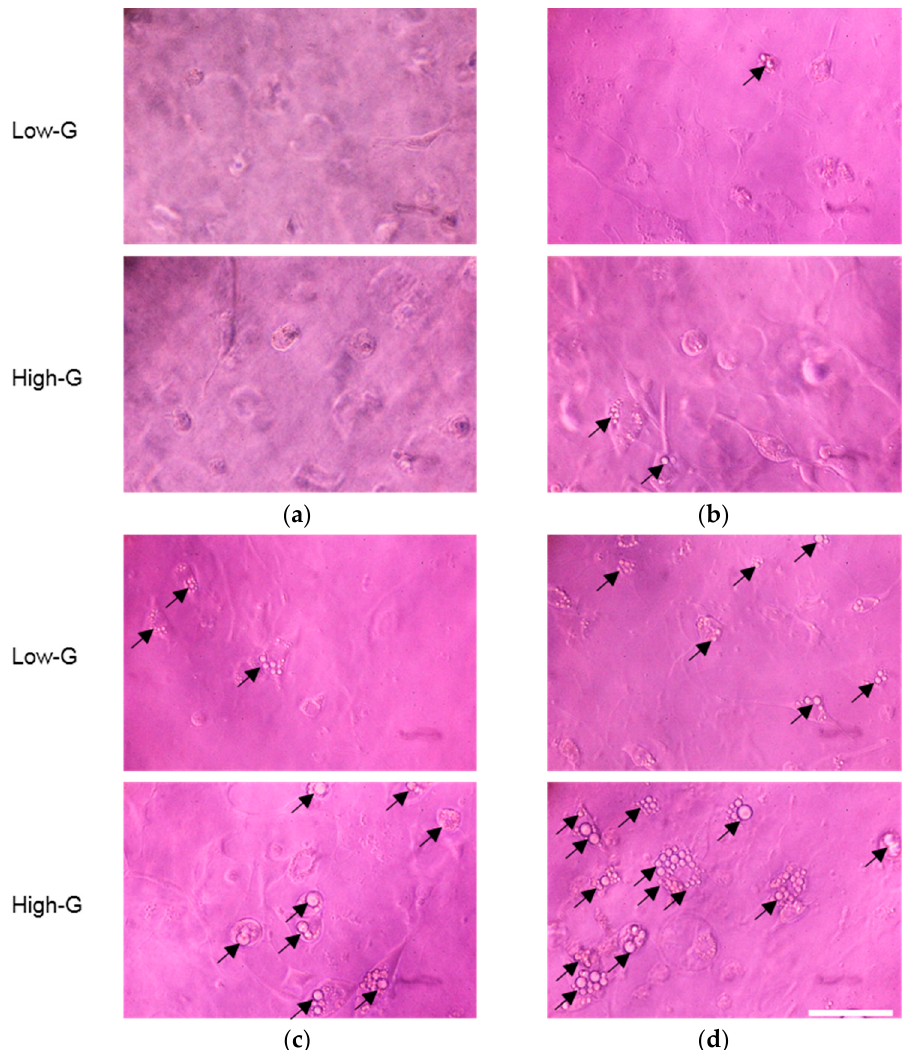
Figure 5. Phase-contrast images of 3T3-L1 cells cultured in collagen gel at ( a ) − 48 h, ( b ) 96 h, ( c ) 192 h, and ( d ) 288 h post adipogenesis. Lipid droplets were accumulated after t = 96 h (black arrows indicate lipid droplets). Scale bar: 50 μ m.